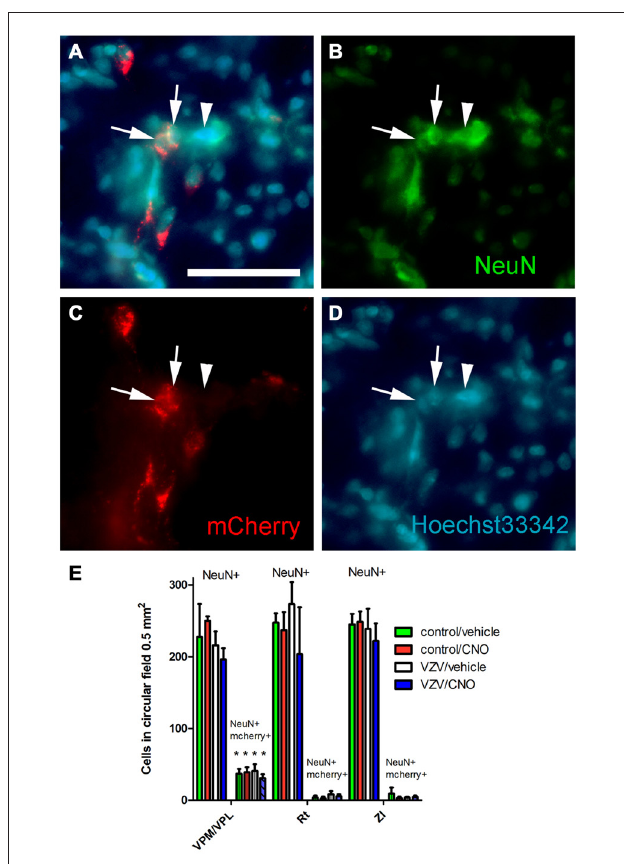
FIGURE 5 | Experiment 3, (A–D) immunofluorescent staining of the VPM/VPL thalamus of a rat 4 weeks after infusion of AAV8-hSyn-hM4D(Gi)-mCherry. The representative brain slice was collected from a rat whose whisker pad was injected with control MeWo cells and given an IP injection of vehicle (0.5% saline). Arrows point to NeuN positive cells expressing mCherry, arrowhead points to NeuN positive cell that did not express mCherry. Nuclei were stained blue with Hoechst 33342. Bar equals 50 micrometers. (E) Histogram of blinded cell counts in circular field 0.5 mm 2 in area, counts were completed in randomly chosen fields adjacent to the injection site in several thalamic regions; the VPM, VPL and reticular (Rt) thalamic nuclei, as well as the zona incerta (ZI). Asterisk indicates p < 0.05 when comparing the NeuN+/mCherry positive cells in the VPM/VPL to the NeuN+/mCherry positive cells in the Rt and ZI. n = 3 for the control/vehicle and control/CNO groups and n = 4 for the VZV/vehicle and VZV/CNO groups. Values are the mean and SEM.